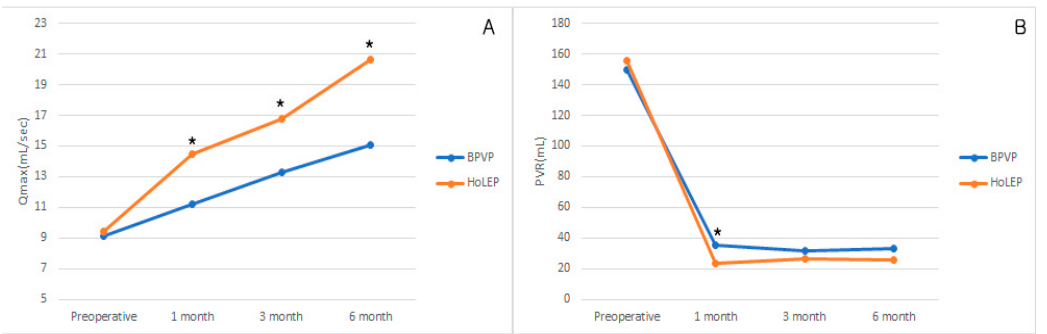
Figure 1. 6-month follow-up data of IPSS, IPSS voiding, IPSS storage, and QoL. ( A ) Qmax and PVR follow-up results of BPVP and HoLEP ( B ), BPVP = bipolar plasma vaporization of prostate, HoLEP = holmium laser enucleation of the prostate, IPSS = international prostate symptom score, Qmax = maximum urinary flow rate, PVR = postvoiding residual volume, * p < 0.05; compared BPVP with HoLEP.